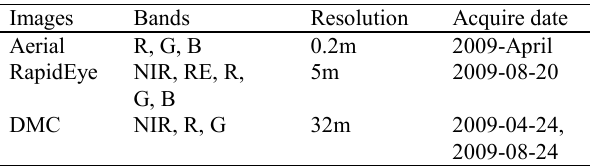
Table 1: Overview of image